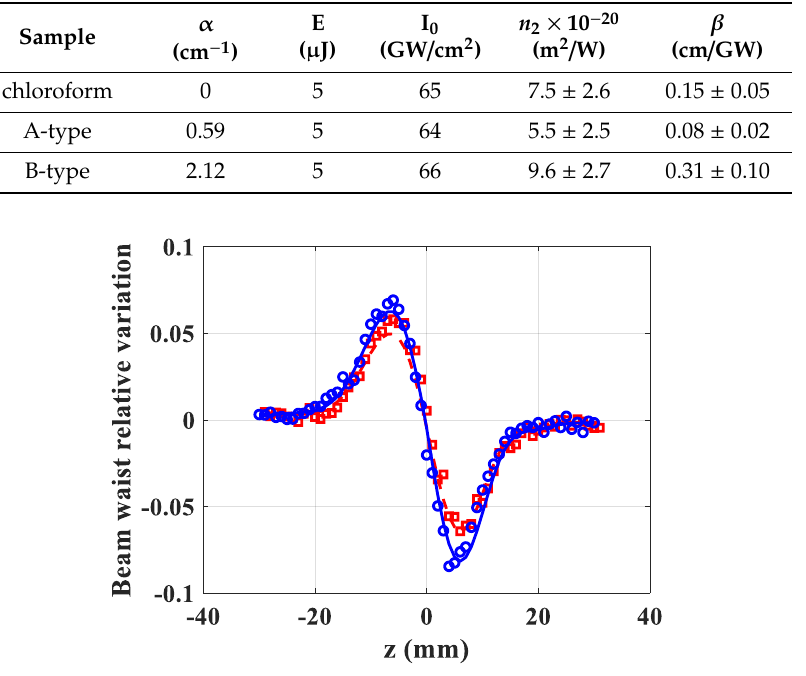
Figure 10. Nonlinear refraction of A and B type suspension of ZnO particles in chloroform at 532 nm (red square: A type; blue circles: B type). Solid and dashed (blue and red) lines are fittings.